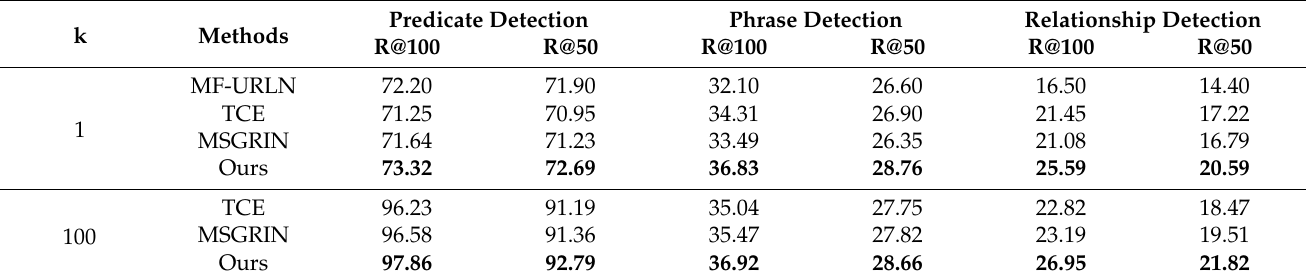
Table 3. Comparison with state-of-the-art methods on VG; bold font indicates the best